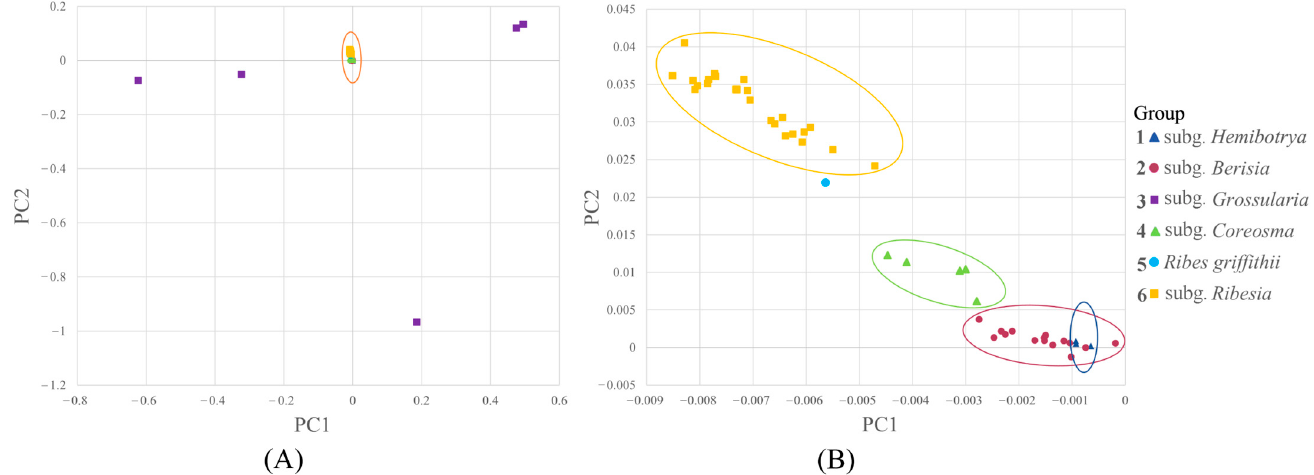
Figure 2. ( A ) Principal component analysis of 30 Ribes L. species. ( B ) Principal component analysis of 27 Ribes L. species.